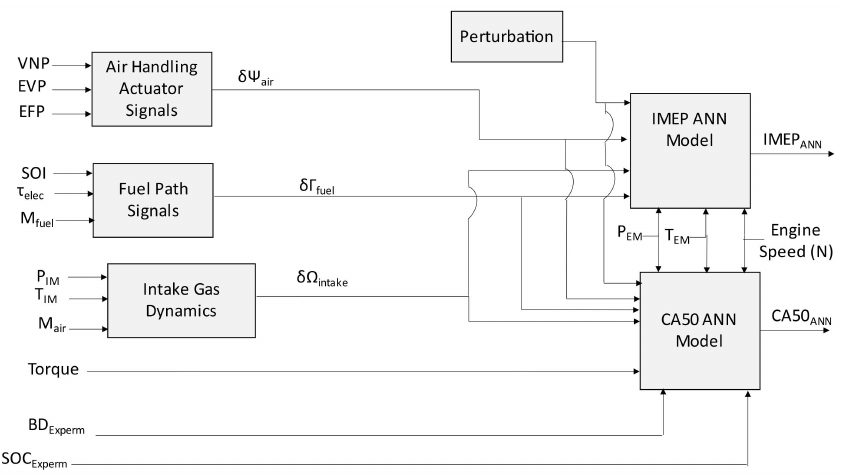
Figure 4. CA50 and IMEP classical ANN model